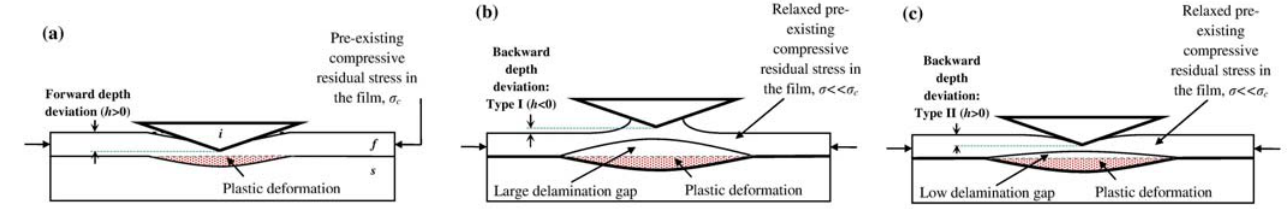
Figure 9. Schematic of nitinol thin film behavior during nano-impact (fatigue) under Berkovich (or conical) indenter showing the types of depth deviation: ( a ) Forward depth deviation. ( b ) Backward depth deviation of type I. ( c ) Backward depth deviation of type II ( f : film, s : substrate, i :